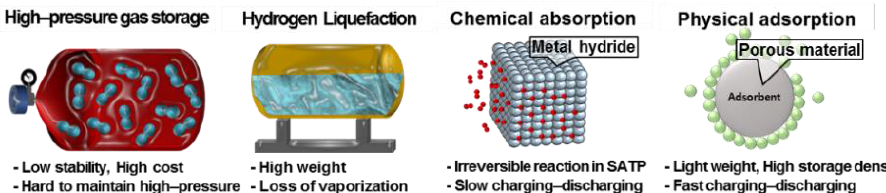
Figure 2. Schematic illustrations of various hydrogen storage techniques.